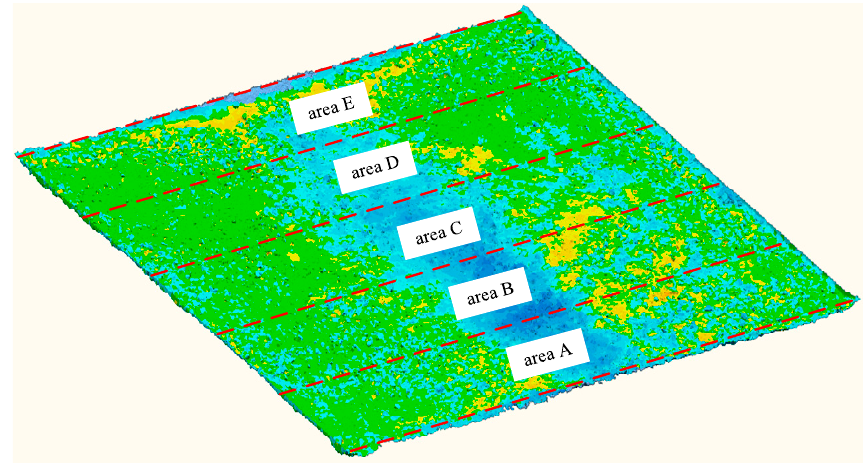
Figure 11. Region division for surface analysis. (1) The changes in average sedimentation in different surface regions are shown in Figure 12. As seen from the figure, all the surface regions saw an increase in the amount of sedimentation, and the increase gradually decreased. After the stability of the strata, the total settlement is the largest in area II, with an average of 1.323 mm, and the smallest overall settlement is observed in area V, with an average of 0.334 mm. Therefore, the early middle stage of the surface in the mined-out area is the area with the largest amount of settlement, and measures need to be taken to focus on prevention and control.